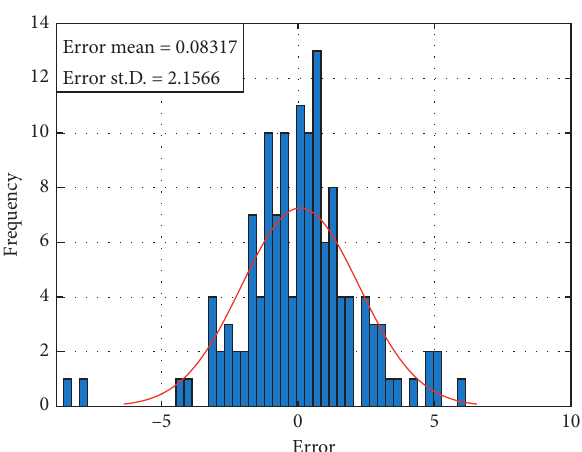
Figure 7: Histogram of error for the training dataset and a fit corresponds to the distribution of error.